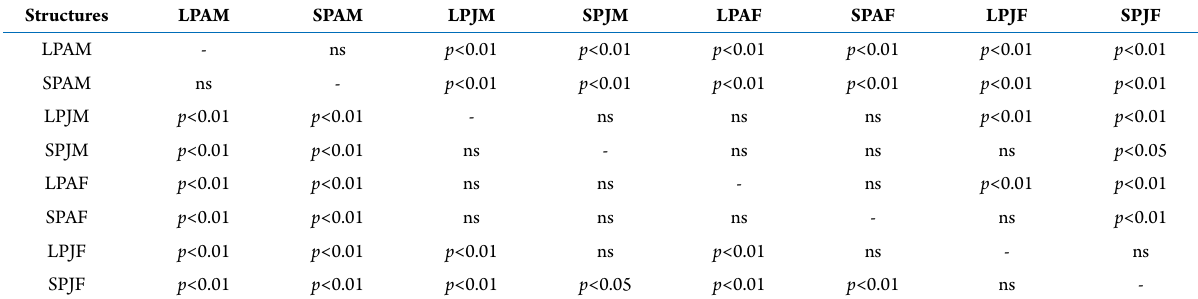
Table 3. Macrobrachium candango Mantelatto, Pileggi, Pantaleão, Magalhães, Villalobos and Álvarez, 2021. Dunn’s test results comparing the propodus length (largest × smallest) between adult and juvenile males and females. LPAM: largest propodus of adult males; SPAM: smallest propodus of adult males; LPJM: largest propodus of juvenile males; SPJM: smallest propodus of juvenile males; LPFM: largest propodus of adult females; SPJF: smallest propodus of adult females; LPJF: largest propodus of juvenile females; SPJF: smallest propodus of juvenile females. ns =